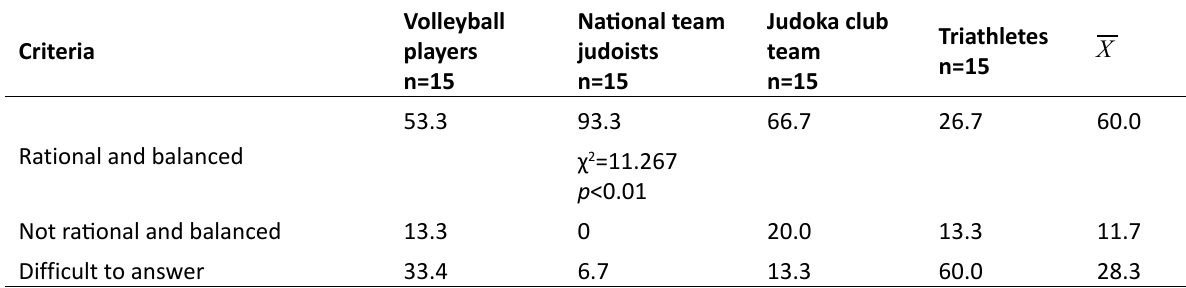
Table 1. The Results of the Participant’s Opinion About Quality of their Nutrition